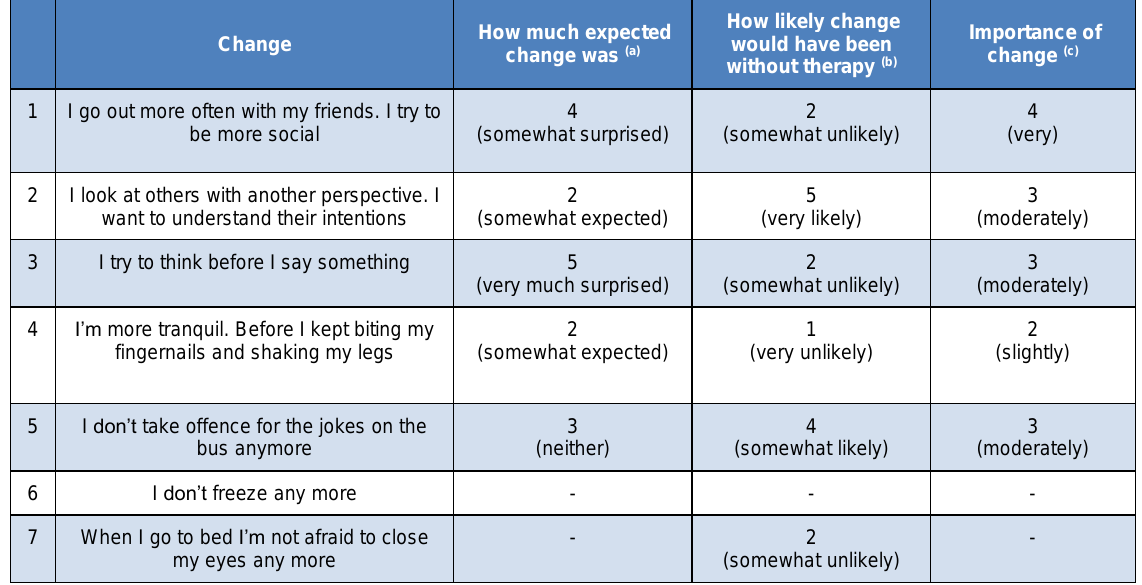
Table 5: Giovanni’s Changes identified in the Change Interview